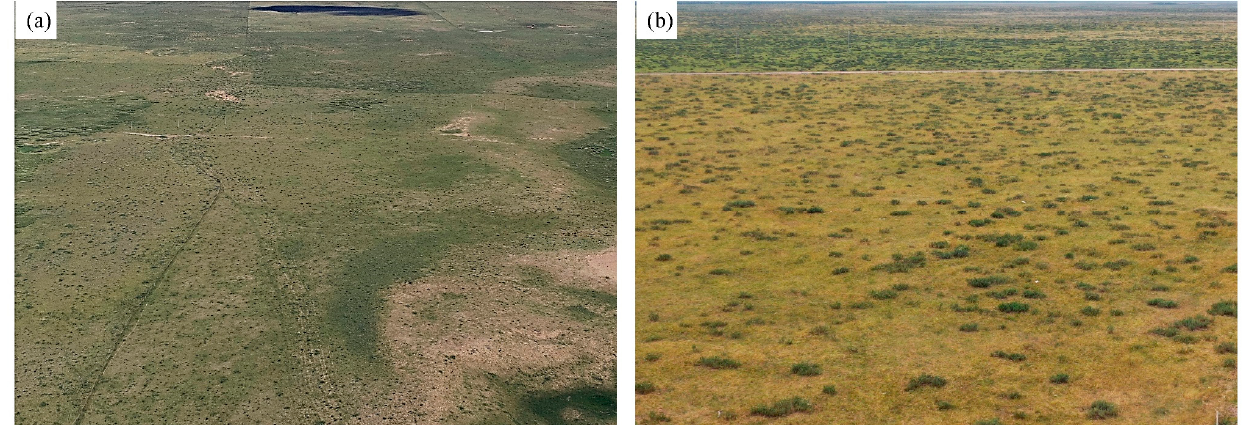
Figure 11. The different growth status of Caragana shrubs in the West (( a ), 43°50 ′ N, 114°47 ′ E) and Middle (( b ), 44°31 ′ N,116°34 ′ E) subregions. Pictures were taken from the field UAV sampling exper- and Middle (( b ), 44 ◦ 31 (cid:48) N,116 ◦ 34 (cid:48) E) subregions. Pictures were taken from the field UAV